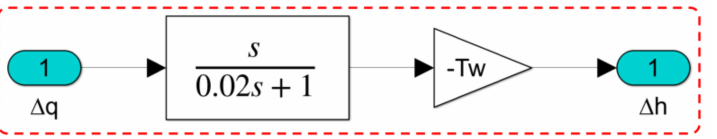
Figure 8. Simulation model of penstock.